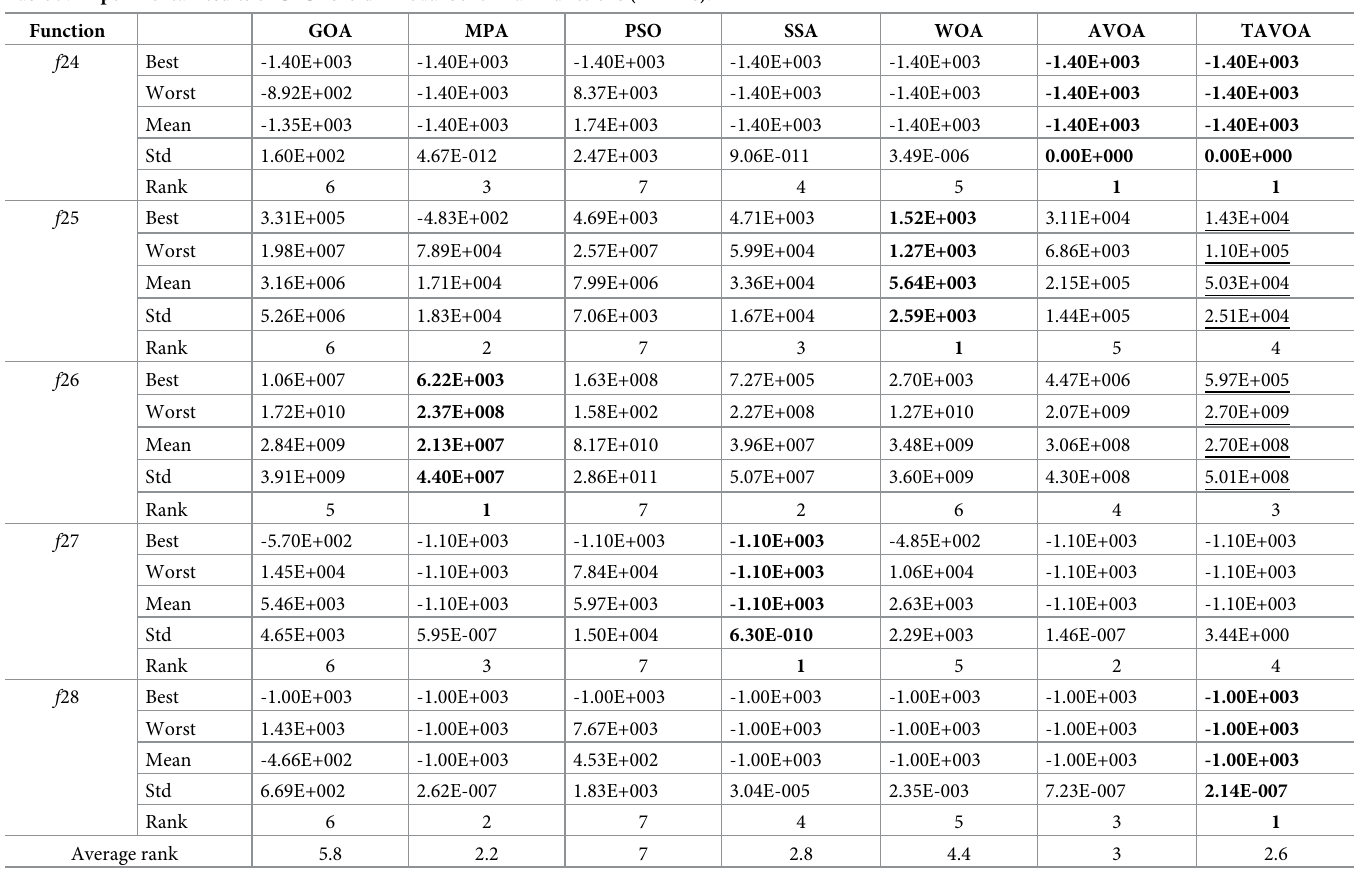
Table 7. Experimental results of CEC 2013 unimodal benchmark functions (f24 − f28).